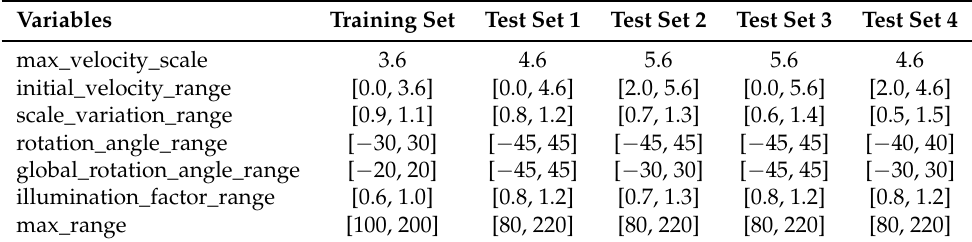
Table A2. Generating settings of the training set and three test sets with different levels of uncertainty. To vary the intensity of images after generating each sample, we randomly generated an integer between max_range and scale the whole sequence to that number.